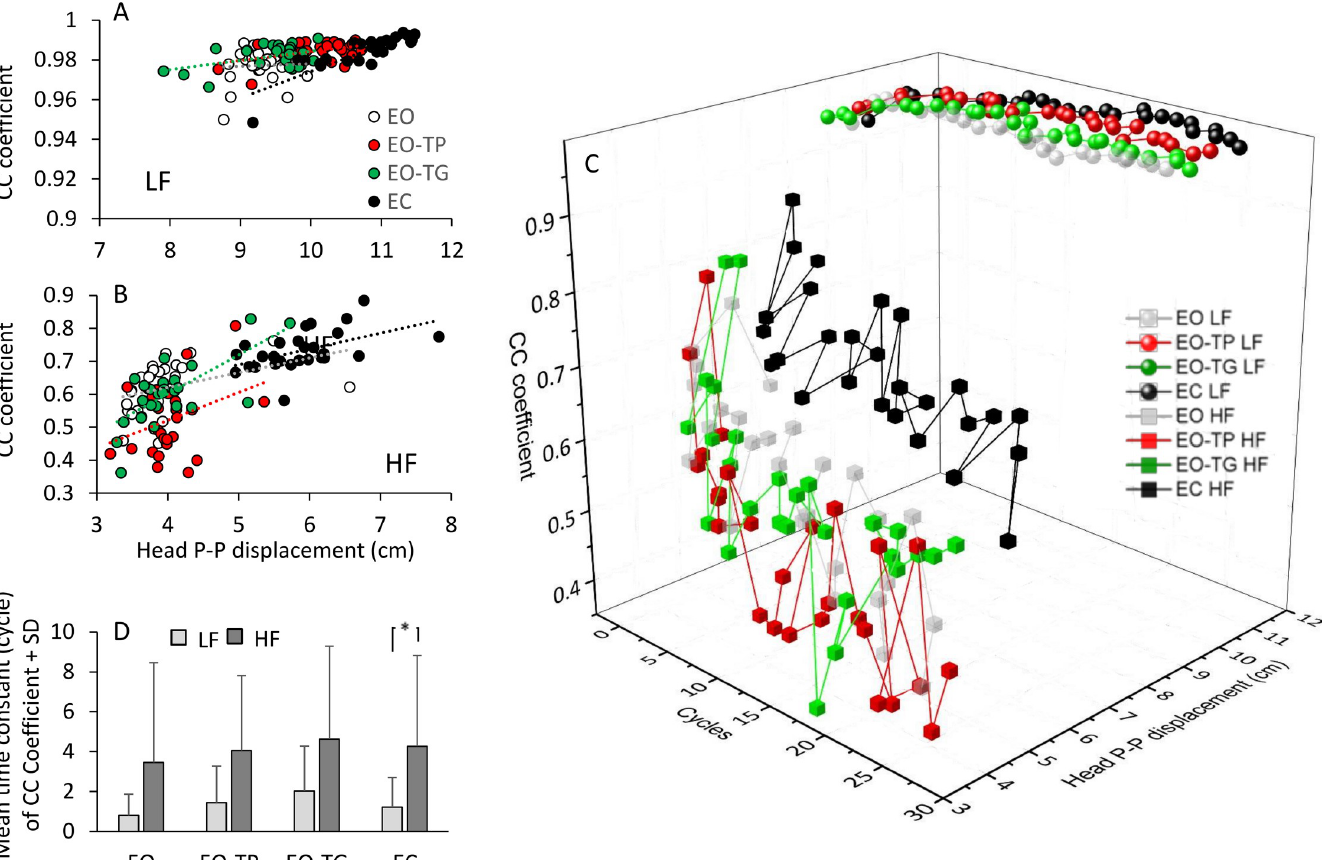
Fig 7. Head PP displacement and CC coefficient covary across cycles. A and B: The mean CC coefficient of each cycle was plotted against the corresponding value of the head PP displacement, for LF (A) and HF (B). White dots refer to EO, red dots to EO-TP, green dots to EO-TG and black dots to EC. C: the mean values of the CC coefficient and of the head PP displacement are plotted against each other and across cycles. Square symbols correspond to HF; circles correspond to LF. White symbols refer to EO, red symbols to EO-TP, green symbols to EO-TG and black symbols to EC. The panel D shows the mean time constant of the CC coefficients under the different conditions. Light grey and dark grey bars refer to LF and HF, respectively. The time constants are always smaller at LF than at HF. The asterisk indicates a significant difference (p < 0.05).